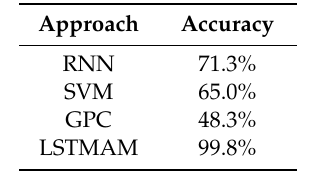
Table 5. The accuracies of di ff erent